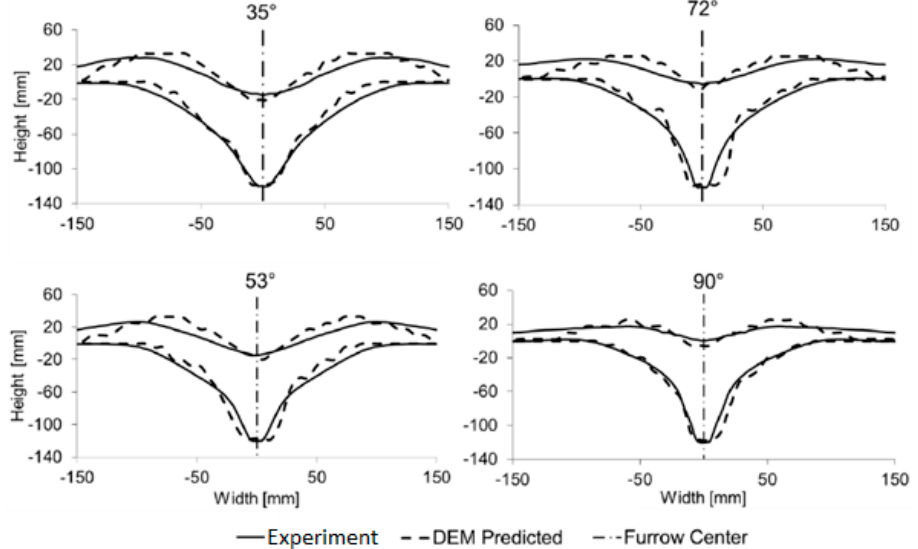
Figure 17. Comparison of furrow profiles for 16 mm wide narrow openers at different rake angles (35°, 53°, 72°, and 90°) obtained from soil bin experiment and DEM simulations. Retrieved and modified from Barr [49].